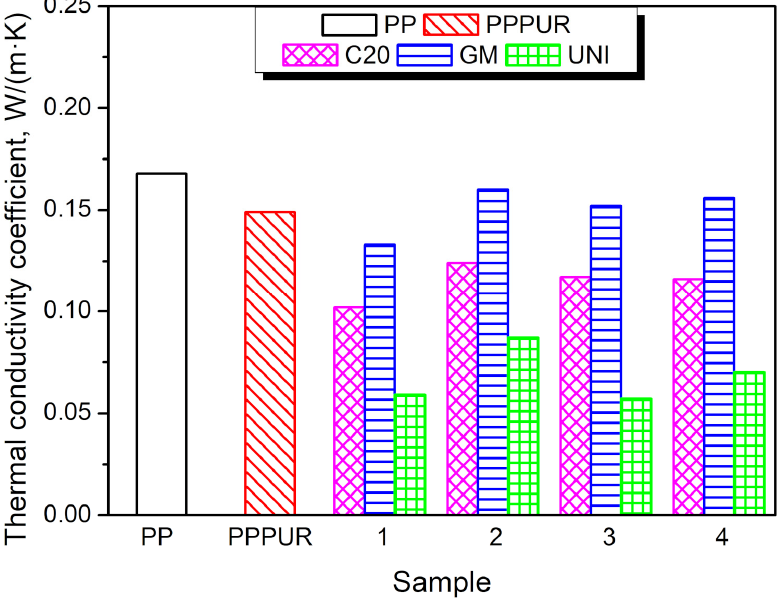
Figure 5. The impact of the applied PP modifications on the thermal conductivity coefficient.